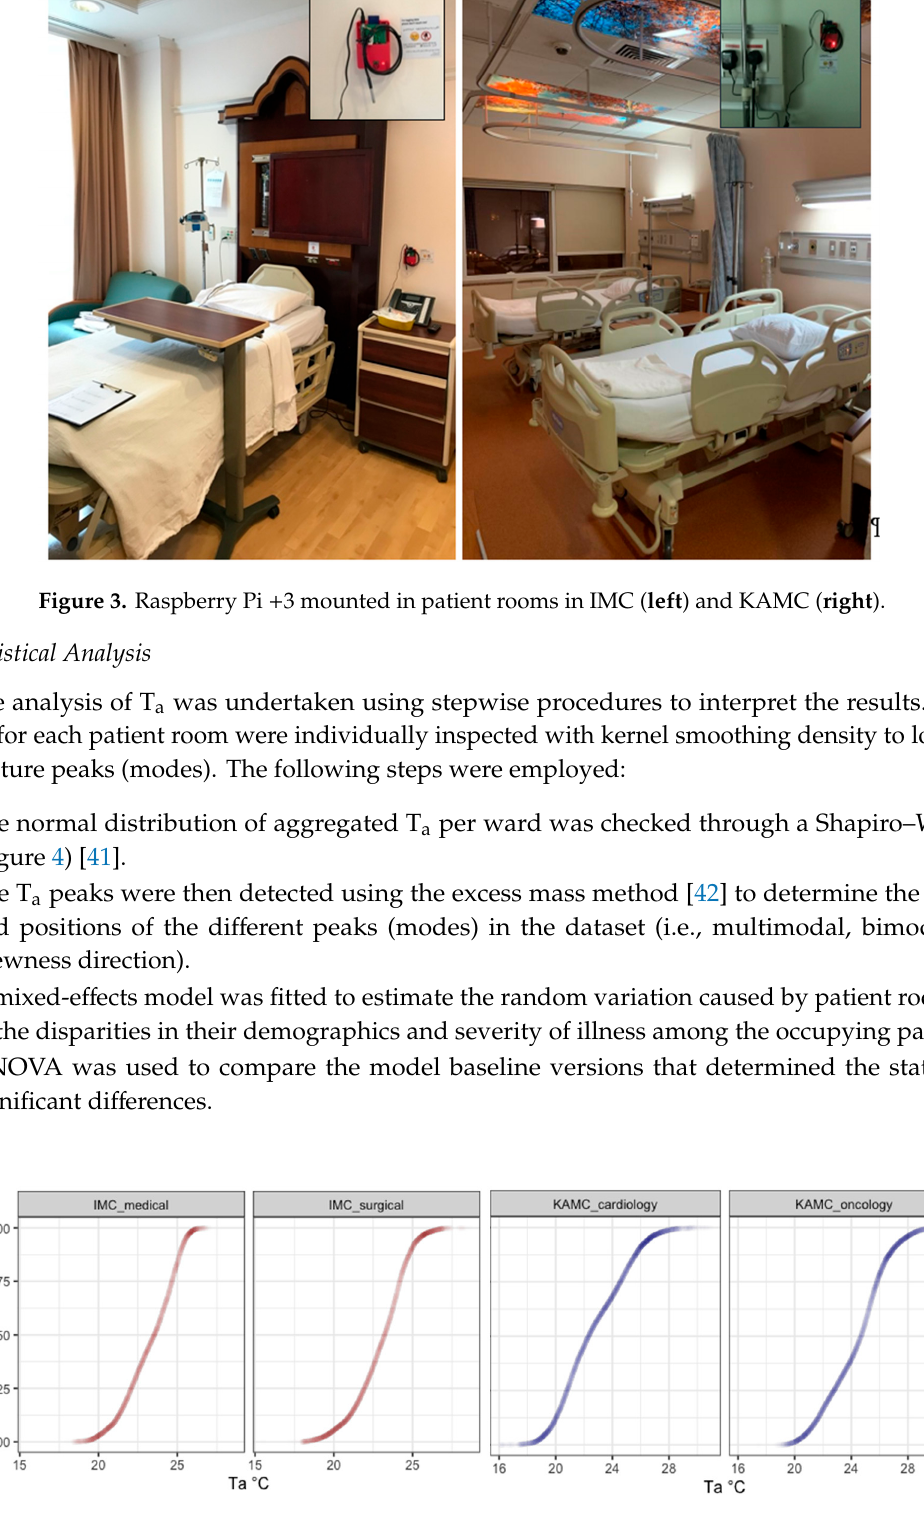
Figure 4. Estimator of Cumulative Distribution Function (CDF) plot showing the normal probability distribution of T a per ward.